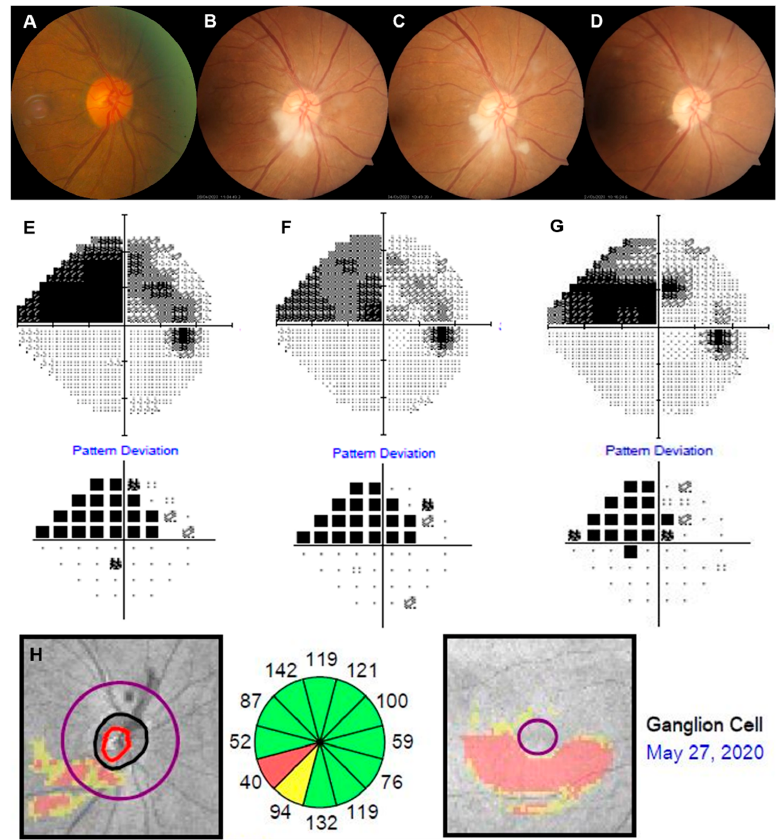
Figure 3. ( A ) Color optic disc photo 6 months before transfemoral cerebral angiography (TFCA) showed no definite abnormality. ( B ) Inferior optic disc edema and peripapillary retinal infarctions were initially found one day following TFCA. ( C ) Seven days after TFCA, steroid pulse therapy was completed, and optic disc edema was slightly resolved. ( D ) Thirty days after TFCA, optic disc edema and peripapillary lesions had almost disappeared. ( E ) The visual field of the right eye showed a superior altitudinal defect one day after TFCA. ( F ) Seven days after TFCA, minimal change in the superior defect in the visual field of the right eye. ( G ) Thirty days after TFCA, supe- rior nasal field defect remained, with minimal improvement. ( H ) Inferior neuroretinal rim thin- ning and retinal nerve fiber layer (RNFL) defect in the inferior temporal quadrant were detected on spectral domain-optical coherence tomography. 3. Discussion One of the largest retrospective studies reported that neurological complications oc- curred in 2.63% of cases after diagnostic cerebral catheter angiography [1]. Factors inde- pendently associated with an increased risk of neurological complications included the indication of atherosclerotic cerebrovascular disease, subarachnoid hemorrhage, and the comorbidity of frequent transient ischemic attacks [1]. Until now, 1.1% of ocular compli- cations such as visual deficits have been reported, even after the successful coil emboliza- tion of carotid ophthalmic aneurysms [4]. This is the first case, to our knowledge, of acute onset quadrant visual field defect after diagnostic TFCA. This patient had a history of clipping of right PCOM aneurysm, which was not directly connected to the ophthalmic artery origin. We can thus hypothesize that microemboli can occur during uncomplicated cerebral angiography. In the literature, microemboli were predominantly detected during